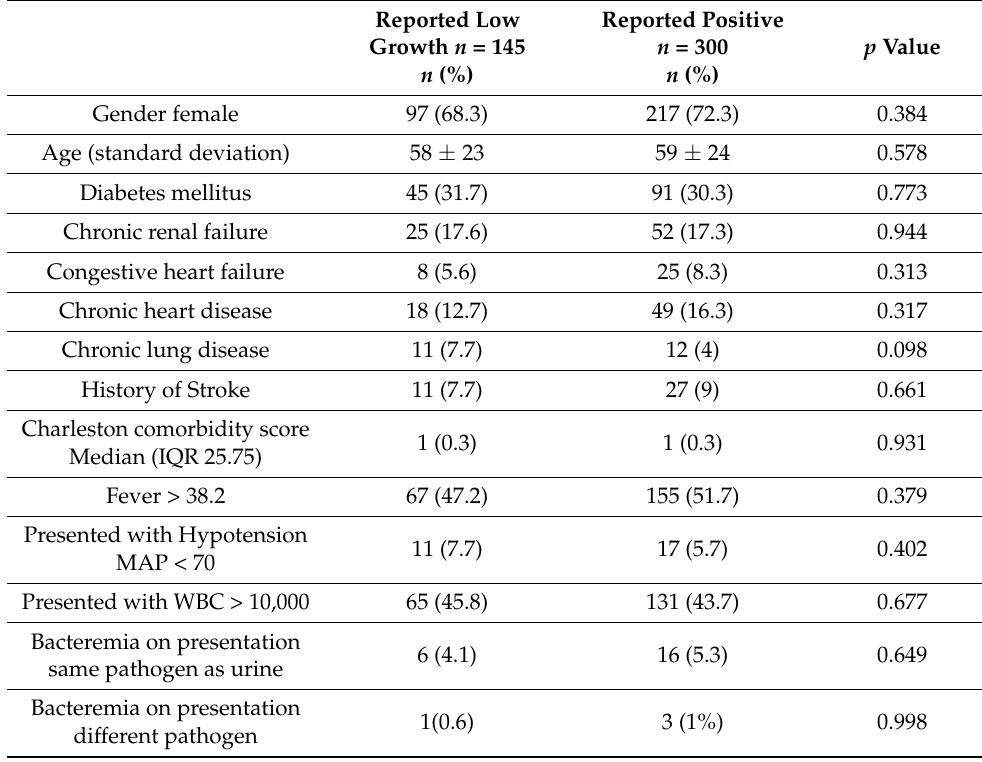
Table 2. Baseline patient characteristics comparing patients with urine culture that were reported as low growth to patients that were reported as positive.